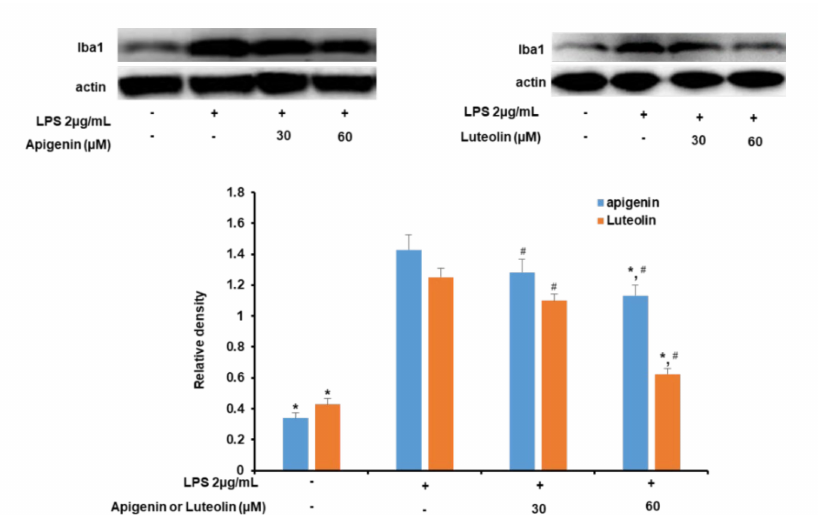
Figure2. ApigeninandluteolininhibitLPS-inducedexpressionofIba1inmicroglialcells. Microgliacells (5 × 10 5 cells / mL) were cultured and pre-treated with apigenin or luteolin at the concentrations of 30 and 60 µ M and then stimulated with LPS for 30 min. The expression level of Iba1was investigated by western blot assay. The band densities were analyzed using ImageJ analysis software, with respect to actin. The results are presented as the mean ± SD ( n = 3). The asterisk (*) indicates significant di ff erent at p < 0.05 compared to the LPS-only treated cells for bars with the same color. The hash (#) indicates a significant di ff erence at # p < 0.05 for bars with di ff erent colors within the same treatment